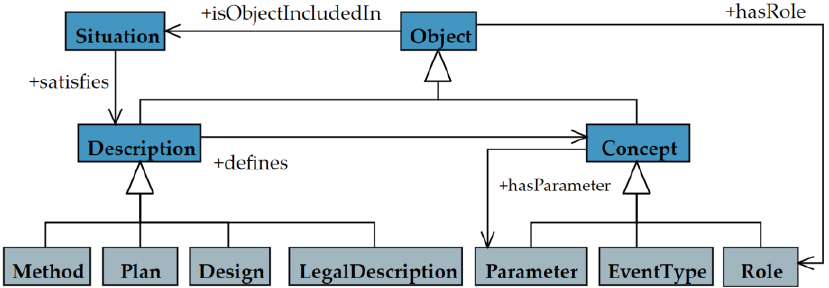
Figure 9. Overview of D&S with